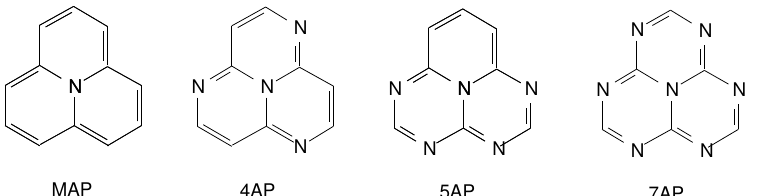
Figure 1. Chemical structures (from left to right) of the molecules MAP (monoazaphenalene or cyclazine), TAP (tetraazaphenalene), 5AP (pentaazaphenalene), and 7AP (heptaazaphenalene or heptazine). Hydrogen atoms are omitted for